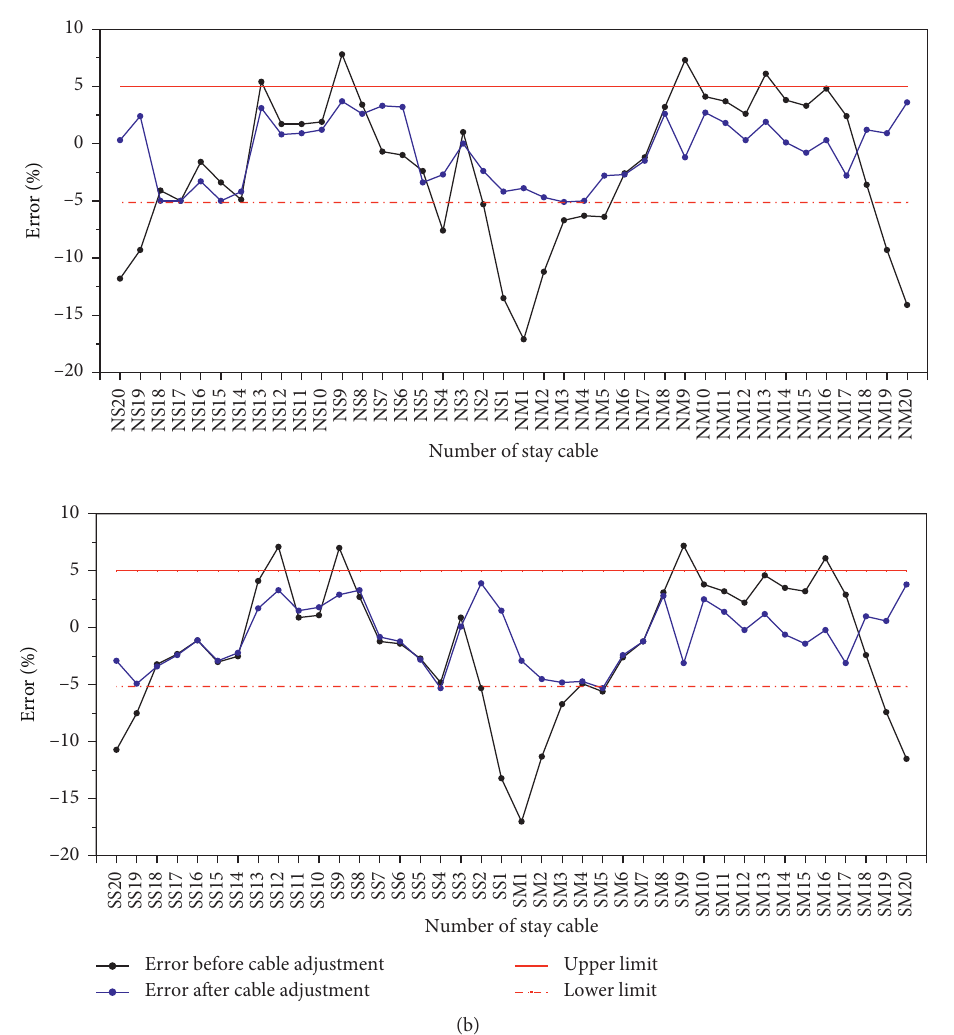
Figure 5: Cable forces before and after adjustments. (a) Cable force value of stay cable. (b) Cable force error of stay